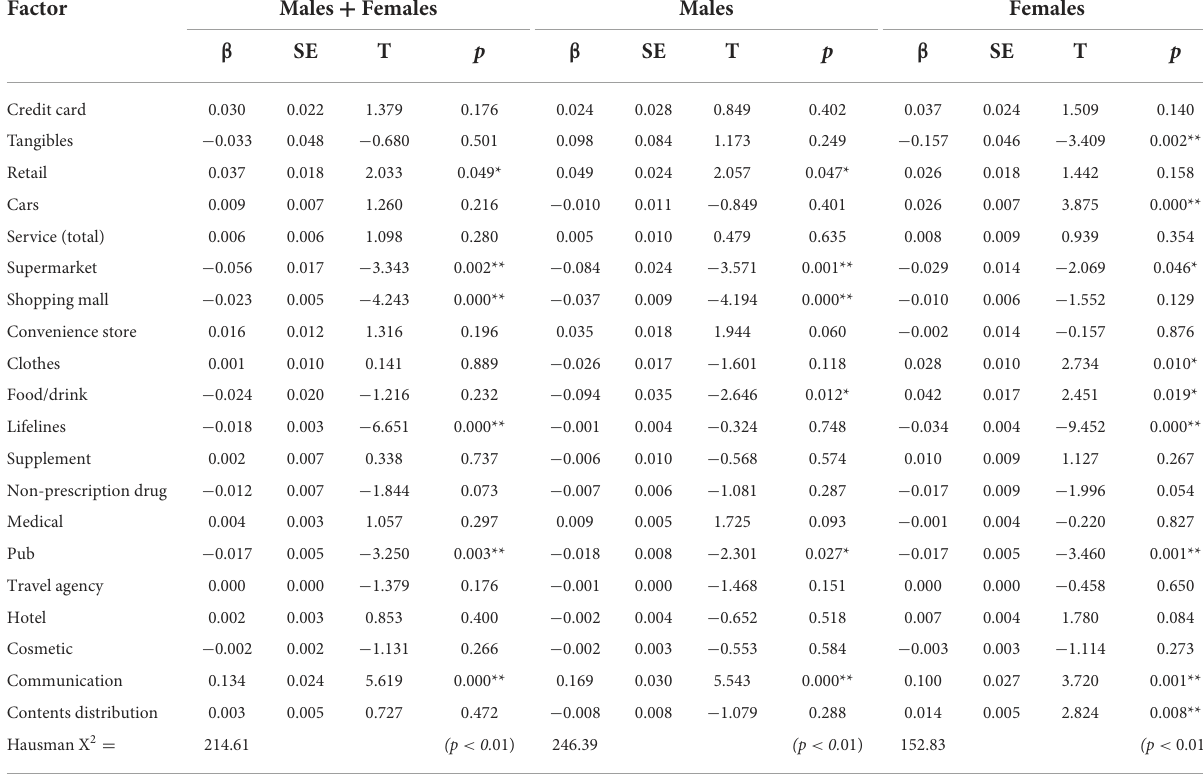
TABLE 2 Relationship between personal consumption expenditures and SDRs for males and females, only males, and only females in the non-metropolitan region during the COVID-19 pandemic (between March 2020 and December